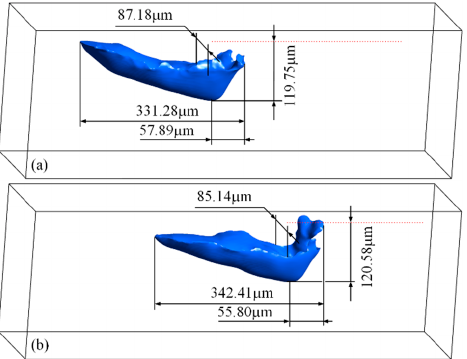
Figure 3. The profile indicated by the liquidus isothermal surface of the molten pool during the laser-scanning process. ( a ) t = 320 μ s; ( b ) t = 480 μ s. The temperature evolution of the characteristic points in the track during the laser- scanning process (the position of these points is marked in Figure 2f,l is shown in Figure 4. When the laser spot passes through those points in the laser path, their temperatures rapidly rise above the liquidus temperature, as shown in Figure 4a, and keep rising and stay above the evaporating temperature for a very short time. Once the temperature ex- ceeds the boiling point, vapor recoil occurs, which strongly drives the melt to flow down- wards, forming a strong convective motion in the molten pool and enhancing the heat transfer. Meanwhile, the liquid surface of the molten pool fiercely shakes, and the tem- perature fluctuates greatly. As the laser passes over, the temperature at the characteristic points gradually drops to near the liquidus, and the melt begins to solidify. Due to the release of the phase-change enthalpy, the cooling rate of the melt is significantly reduced near the liquidus. The temperature history also tells that the liquid-phase lifetime of the